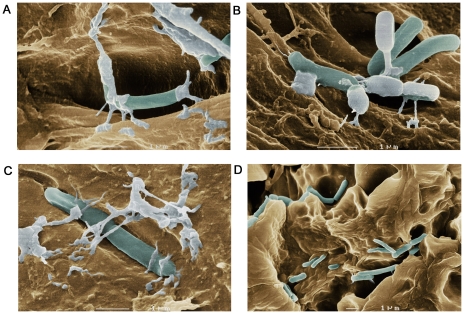

In vitro visualization of lactobacilli.
In vitro visualization of lactobacilli attached to the wall of a honeybee crop using SEM. A, B and C show different areas of a honey crop at similar magnification with visible attachment structures resembling extracellular polymeric substances (EPS). D shows a larger part of the crop with attached bacteria. Photographer Lennart Nilsson.